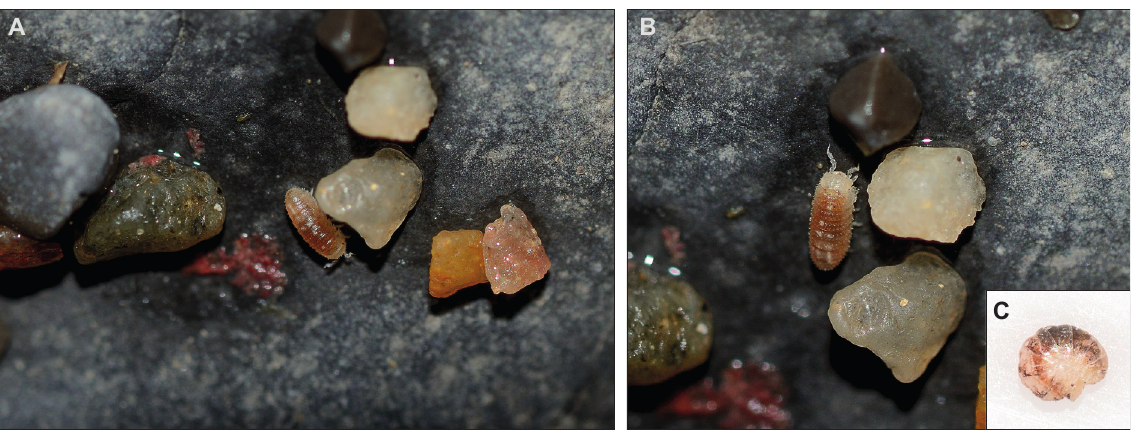
Fig. 2. A–B . Alive specimens of Buchnerillo atlanticus sp. nov. in their habitat (photo: N. Noval). C . Buchnerillo atlanticus sp. nov. conglobated after suffering a disturbance (photo: M. Álvarez Fidalgo).